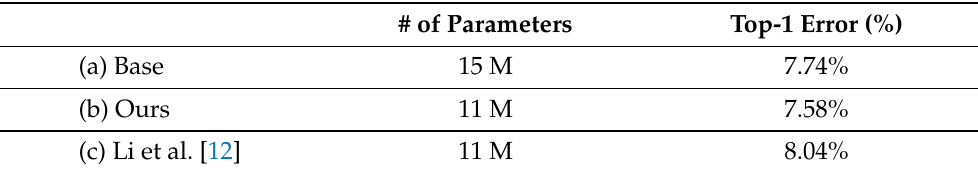
Table 2. Classifier pruning results using the proposed pruning method and existing pruning method [12]: the existing pruning method (c) was pruned to have the same number of channels as the result of the proposed method